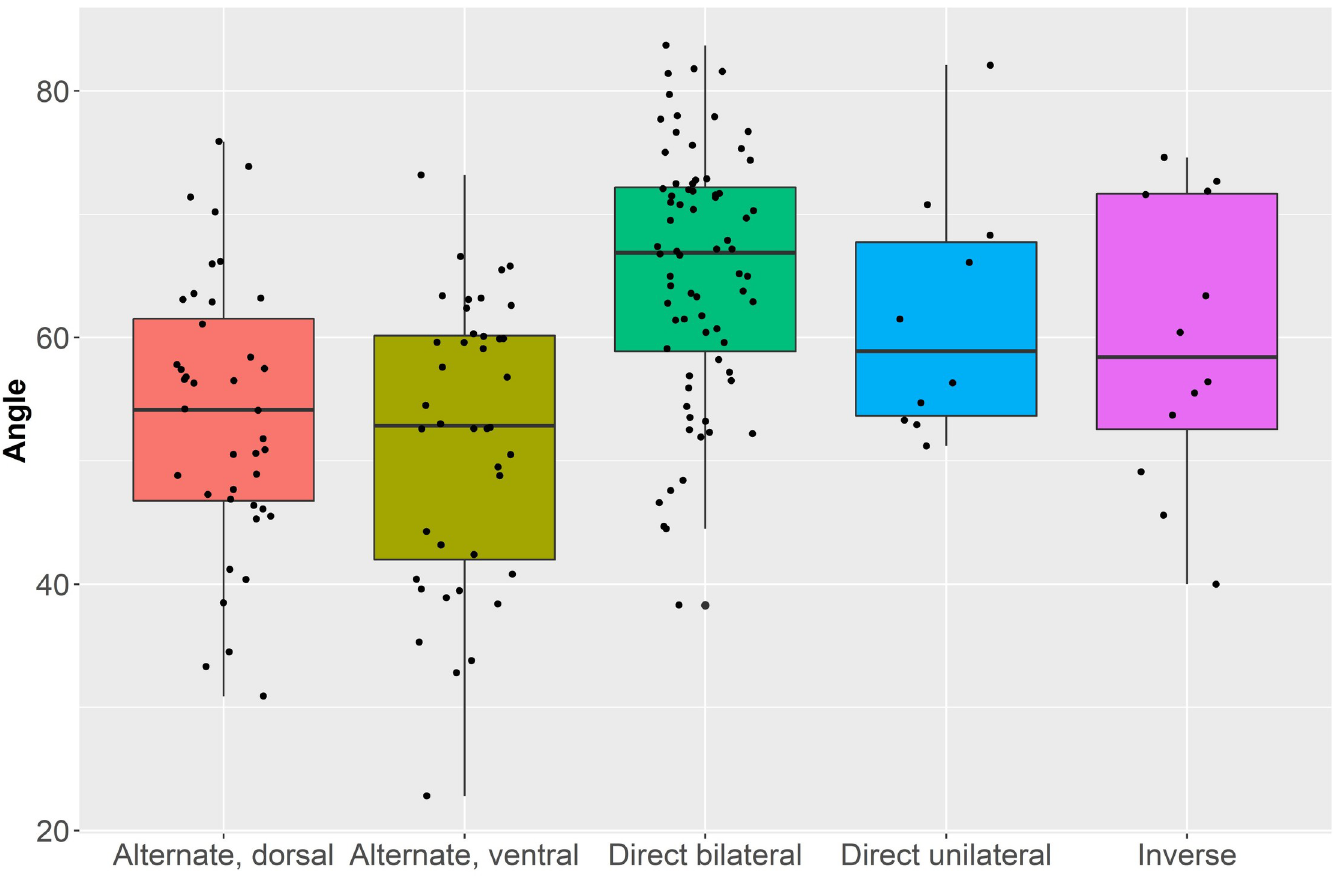
Fig 10. Boxplots with jittered points of mean retouch angles (in degrees) of retouched bladelets grouped according to retouch position (i.e., alternate, direct bilateral, direct unilateral, and inverse) and localization (i.e., dorsal or ventral). In the case of bladelets with direct bilateral retouch, dorsal left and dorsal right retouch computations were combined after finding no significant differences between the two